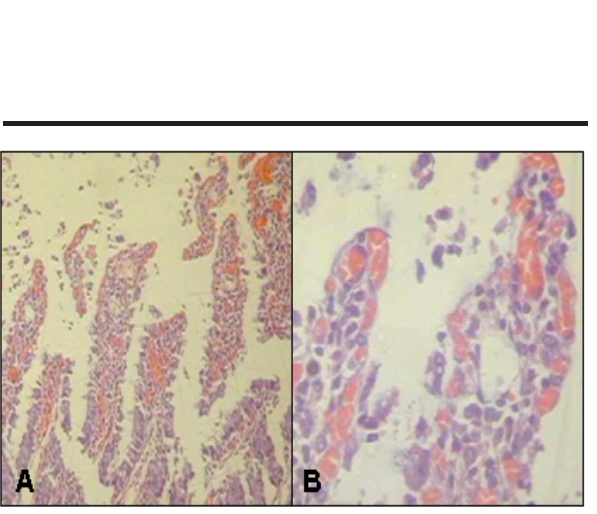
FIGURE 6 - Microphotograph of level 3 of Chiu’s Score’ of intestinal mucosa (HE, A x100, B x400)